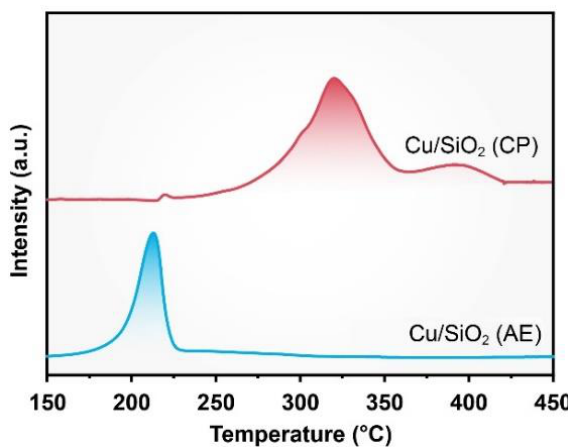
Figure 4. H 2 -TPR profiles of the Cu/SiO 2 (CP) and Cu/SiO 2 (AE) catalysts after calcination. XPS spectra of the Cu/SiO 2 catalysts are shown in Figure 5a. No peak at 940–945 eV is found for the Cu/SiO 2 (AE) catalyst, indicating that Cu 2+ is totally reduced to Cu + or Cu 0 [14,16,29], and the two peaks with binding energies at ~932 eV and 952 eV are assigned to the 2P 3/2 and 2P 1/2 of Cu + or Cu 0 [29,37]. The Cu/SiO 2 (CP) catalyst shows a peak at 940–945 eV related to Cu 2+ , indicating the incomplete reduction of CuO. This is consistent with the results of XRD and H 2 -TPR. The peak with binding energy at ~935 eV may be related to the 2P 3/2 of Cu 2+ [22,27]. The peak with binding energy at 952 eV is assigned to the 2P 1/2 of Cu 0 [22]. To further analyze the content of Cu + and Cu 0 , the Cu LMM auger spectra is investigated (Figure 5b). For the Cu/SiO 2 (CP) catalyst, the peak between 910–925 eV is divided into two peaks at 916 eV and 919 eV, which are ascribed to Cu + and Cu 0 species [26,38]. Accordingly, the Cu/SiO 2 (AE) catalyst shows two peaks for Cu + and Cu 0 species at 915 eV and 920 eV, respectively [38]. For the Cu/SiO 2 (AE) catalyst, the Cu + /(Cu 0 + Cu + ) intensity ratio, obtained by fitting the Cu LMM peaks, is 32%, higher than that of Cu/SiO 2 (CP) catalyst (22%) (Table 1) [14]. The NH 3 -TPD profiles of Cu/SiO 2 catalysts are shown in Figure 6. For the Cu/SiO 2 (CP) catalyst, the peaks at 90–240 ◦ C and 330–530 ◦ C are attributed to the desorption of NH 3 at weak and strong acid sites. The acid amounts of weak acid and strong acid are 0.03 mmol · g − 1 and 0.12 mmol · g − 1 , respectively. Additionally, the NH 3 desorption peaks at 90–230 ◦ C and 235–370 ◦ C are attributed to the desorption of NH 3 at weak and moderate acid sites for the Cu/SiO 2 (AE) catalyst [26], and the acid amounts of the weak and moderate sites are 0.08 mmol · g − 1 and 0.06 mmol · g − 1 . The report shows that pure CuO and SiO 2 have almost no acidity, and the acid sites of Cu/SiO 2 may be related to the low state copper species, such as Cu + [26,39]. Cu/SiO 2 (AE) catalyst shows more weak acid sites versus the Cu/SiO 2 (CP) catalyst, suggesting that the increased acid sites for the Cu/SiO 2 (AE) catalyst may originate from the higher content of Cu + confirmed by XPS